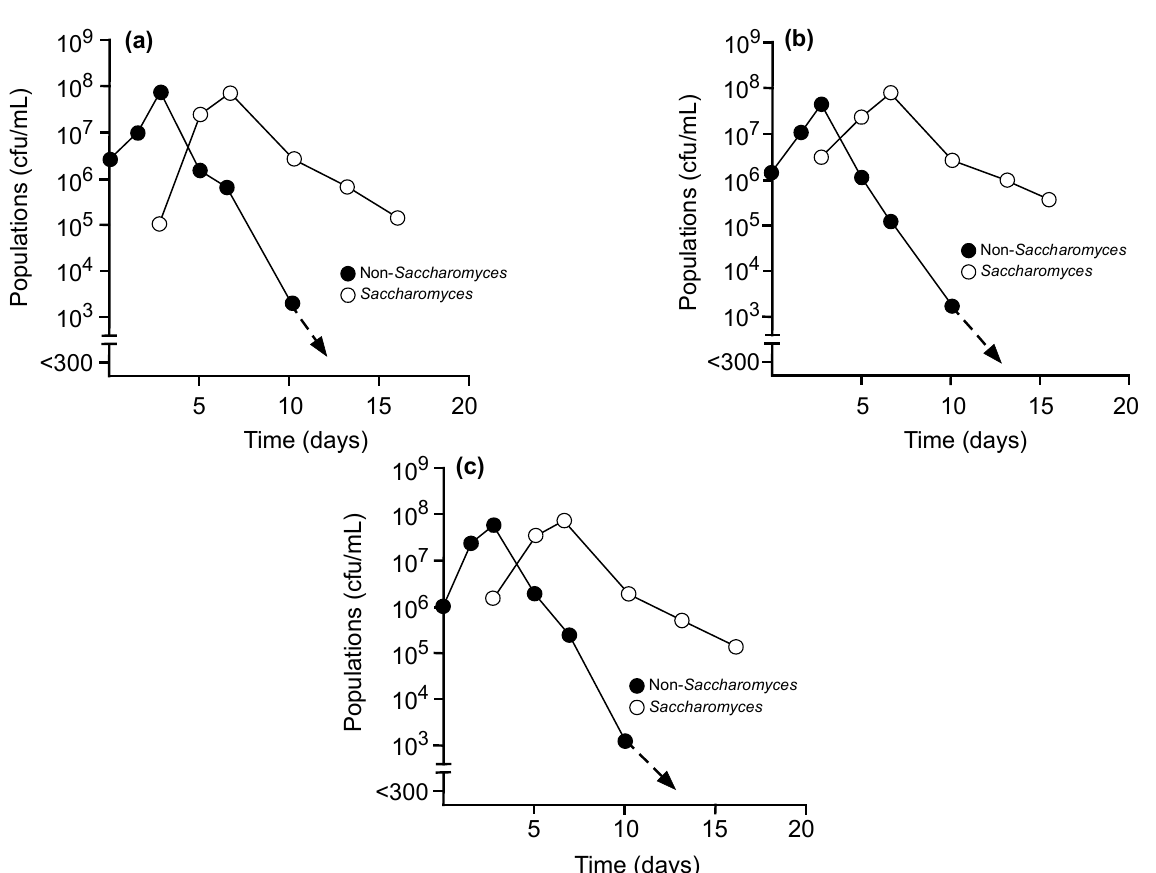
Figure 2. Culturable populations of total non- Saccharomyces yeasts ( ● ) or Saccharomyces cerevisiae ( ○ ) in Merlot grape musts where Mt. pulcherrima P01A016 ( a ), Mt. pulcherrima NS-MP ( b ), or My. guilliermondii P40D002 ( c ) were inoculated on day 0 with Saccharomyces cerevisiae added on day 3.